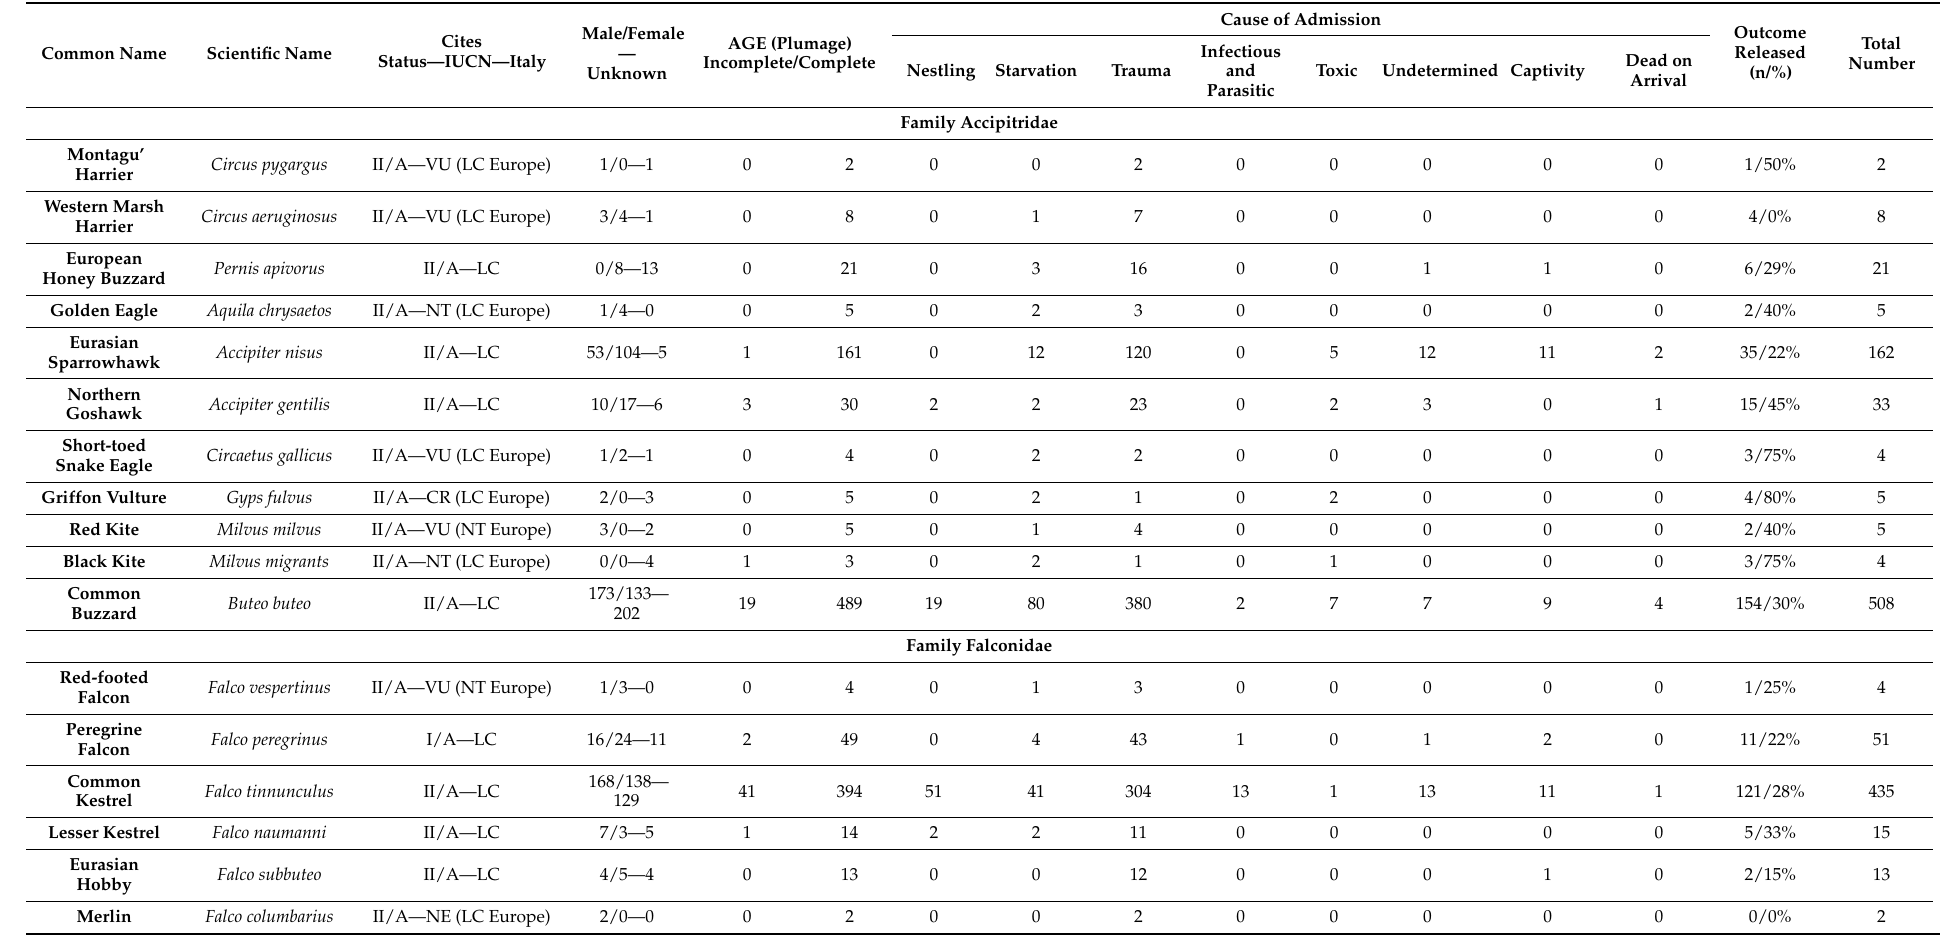
Table 1. Population characteristics of birds of prey admitted to the wildlife rehabilitation center of Pescara (Abruzzo, Italy) between 2005 and 2016, including causes of admission and release rate. IUCN classification and CITES status available at https://www.iucnredlist.org/ (accessed on 26 September